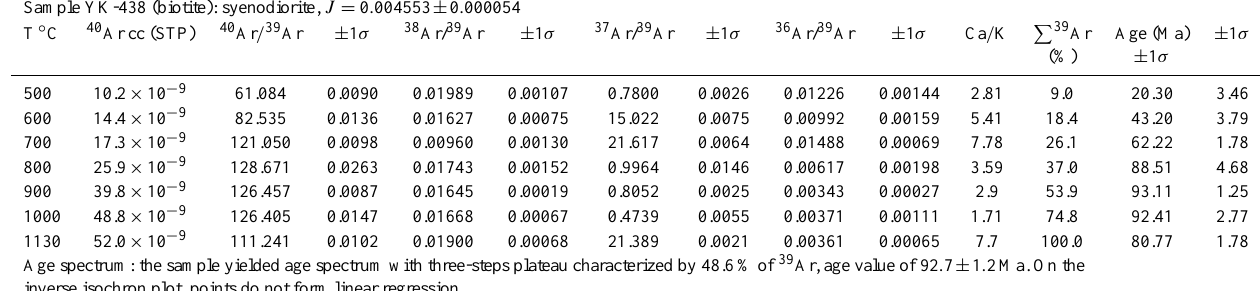
Table 4d. 40 Ar/ 39 Ar biotite age data for a syeno-diorite plutonic rock (Sample No. YK-438) from the island- arc unit in the Ankara Mélange, Turkey. 973 Sample: YK-438 (biotite): Syeno- diorite, J=0.004553 ±